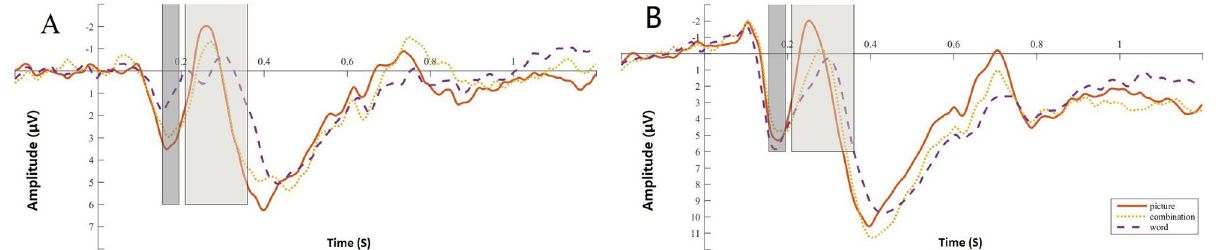
Figure 7. Difference wave and latency in the Go/No-go task: ( A ) difference wave between target and nontarget; ( B ) mean amplitude of